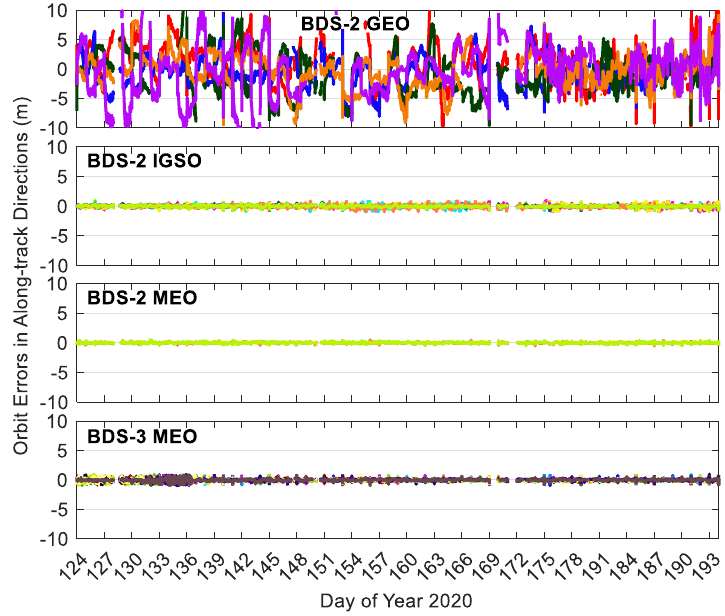
Figure 9. Along-track errors of BDS-3/BDS-2 precise satellite orbits in the real-time situation. Different colors in the figure refer to different satellites. Sensors 2020 , 20 , x FOR PEER REVIEW